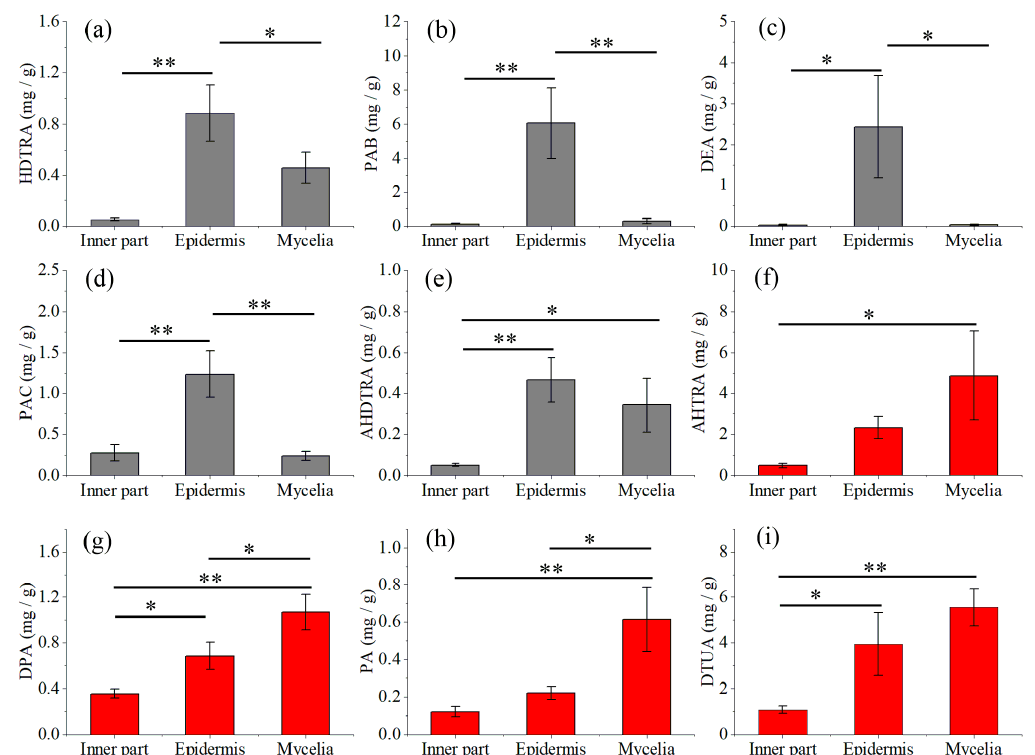
Figure 4. Quantitative comparison of the content of triterpene acids HDTRA ( a ), PAB ( b ), DEA ( c ), PAC ( d ), AHDTRA ( e ), AHTRA ( f ), DPA ( g ), PA ( h ) and DTUA ( i ) in the inner part, epidermis and mycelia of P. cocos ; data are mean ± SD (* p < 0.05, ** p < 0.01).